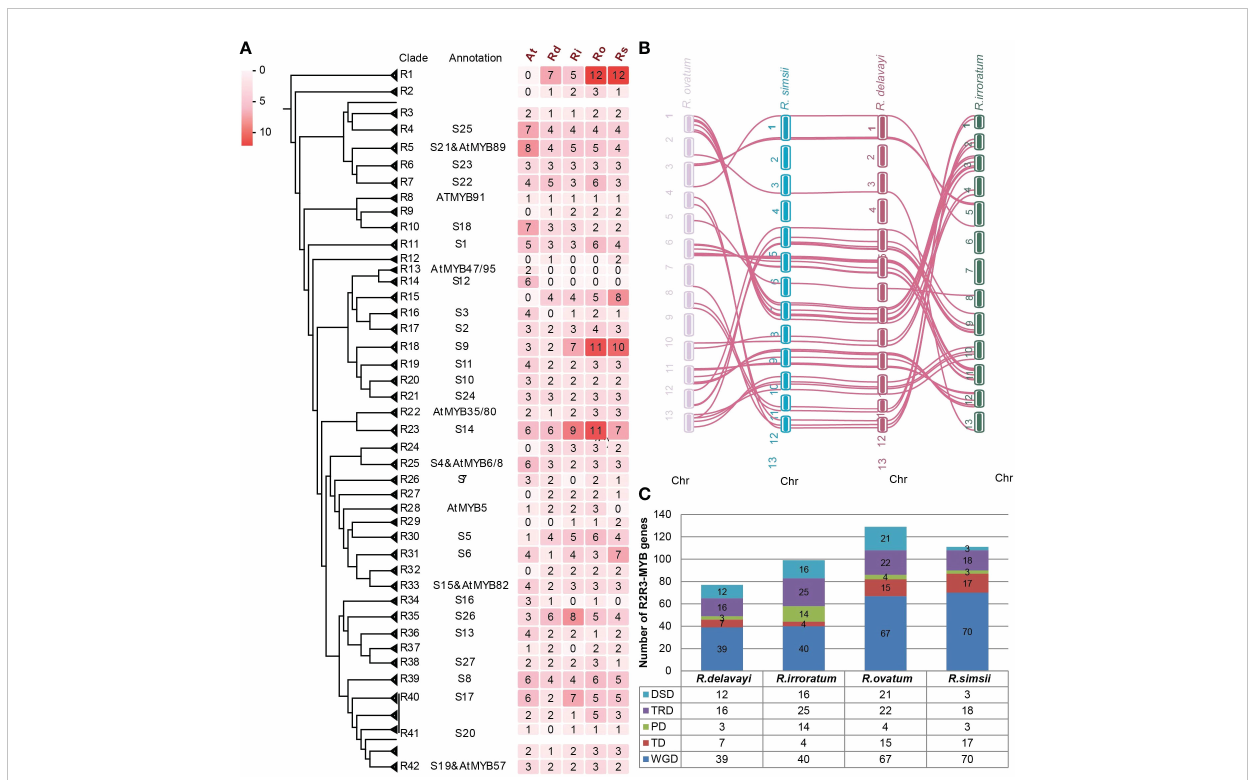
FIGURE 4 Comparative evolutionary analysis of the R2R3-MYB subfamily members in Rhododendron . (A) Phylogenetic tree of R2R3-MYB members from four Rhododendron species and Arabidopsis . The folding triangles represented the 42 de fi ned subgroups (R1 to R42). One protein from R. delavayi (line) did not fi t well into subgroups. Subgroups clustered with Arabidopsis R2R3-MYB proteins were annotated with designated A thaliana subgroups as previously reported (Dubos et al., 2010). Number of subgroup members for each species was indicated by the heatmap. The uncompressed tree was shown in Supplementary Figure S13. (B) Interspecies synteny of R2R3-MYB genes among four Rhododendron genomes; (C) Number of R2R3-MYB genes produced by distinct gene